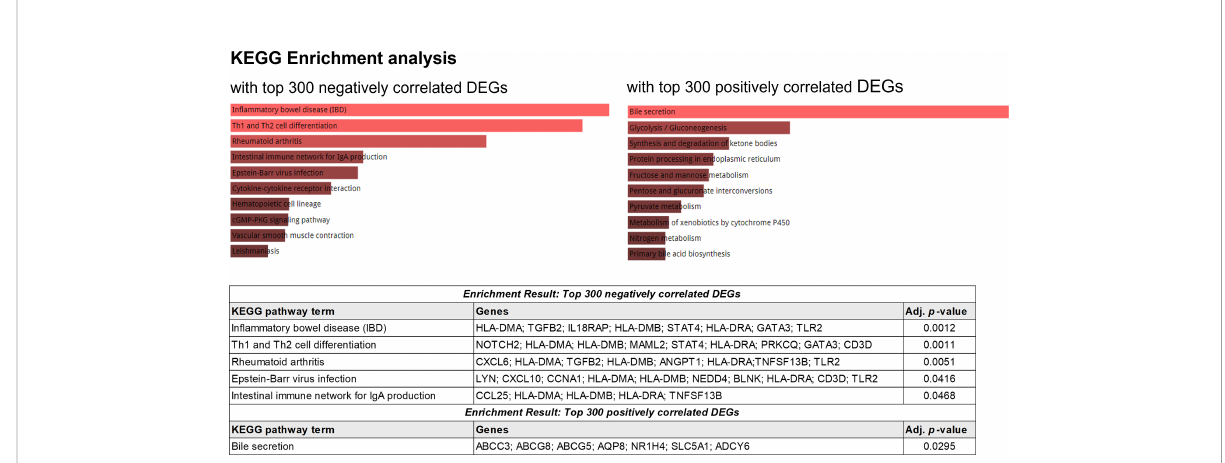
FIGURE 8 KEGG enrichment analysis using the top 300 genes showing positive correlations with the frequency of